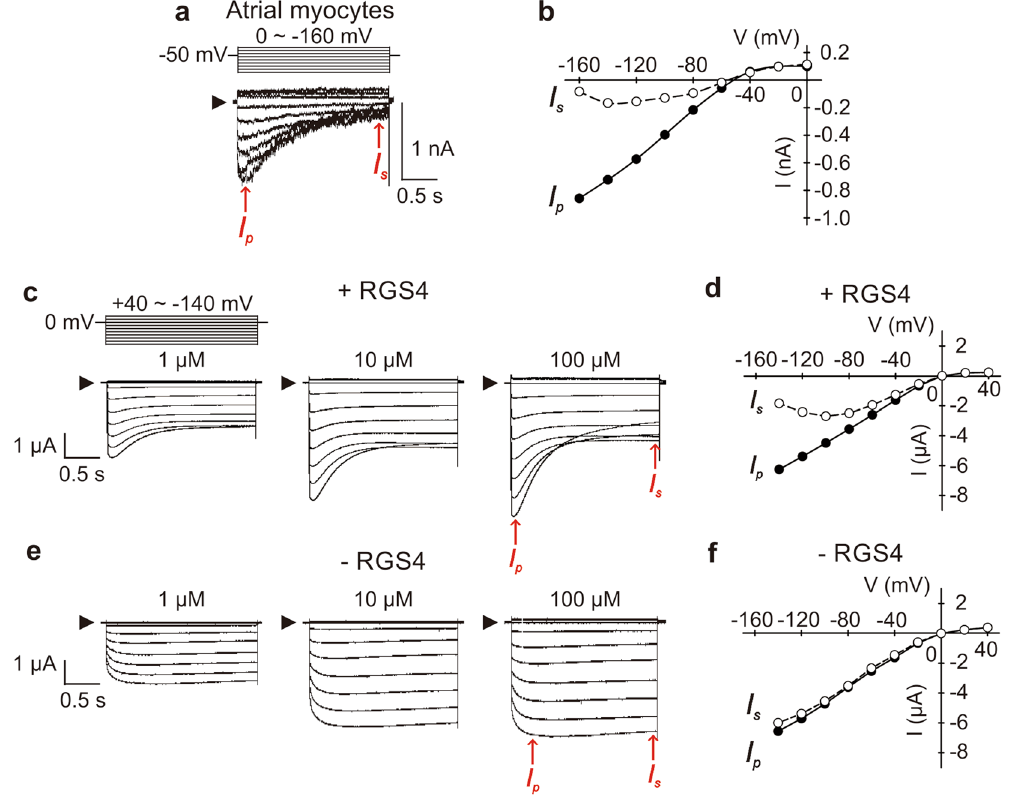
Figure 1. Voltage-dependent response of pilocarpine-induced GIRK currents in rat atrial myocytes and Xenopus oocytes. ( a ) Pilocarpine (100 µ M)-induced GIRK currents in rat atrial myocytes were recorded with a step pulse protocol as shown above the current traces. Basal currents were subtracted. ( b ) I-V curve of pilocarpine-induced GIRK currents in atrial myocytes. I p (filled circles) indicates the peak current at an activated state of GIRK channel; I s (open circles) indicates the steady-state current at the end of the voltage pulse. Red arrows in a were used to reconstruct the I-V curve in b . ( c – f ) Pilocarpine (1, 10, 100 μ M)-induced GIRK currents in Xenopus oocytes expressing M2 muscarinic receptor, Kir3.1/Kir3.4 with ( c , d ) and without ( e , f ) RGS4 were recorded with a step pulse protocol shown above. Basal currents were subtracted. Amplitudes of I p and I s indicated by red arrows in c and e were used to reconstruct the I-V curve in d and f